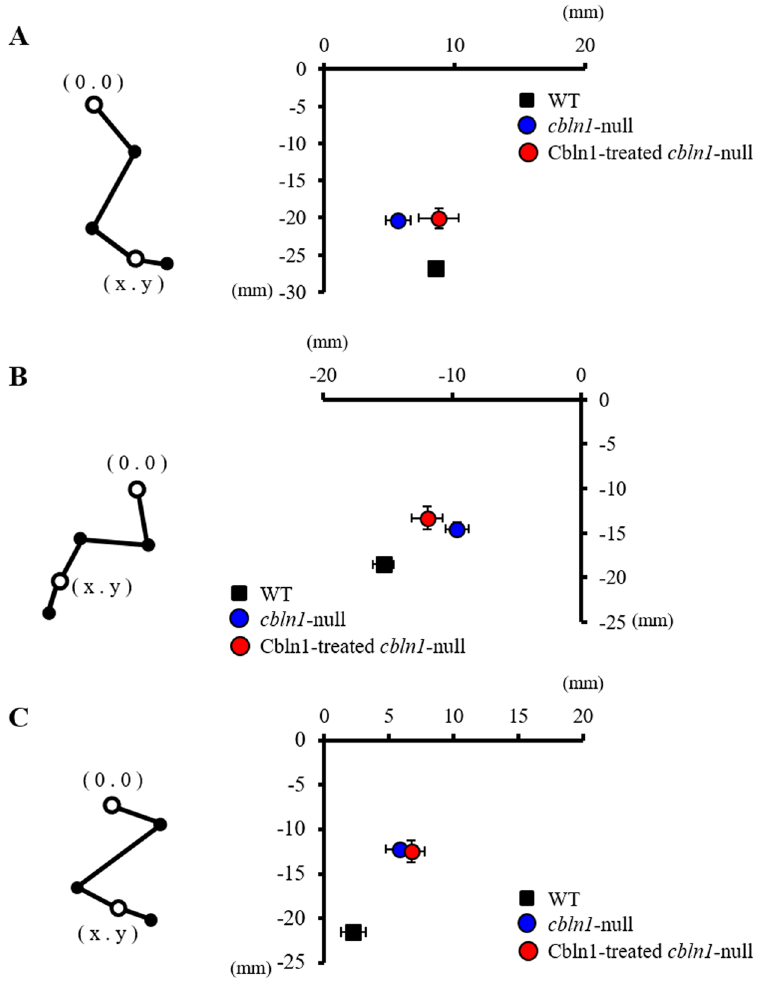
Figure 8. Position of the metatarsophalangeal (MTP) joint during the step cycle. Position of the MTP joint using the great trochanter as the origin. ( A ) Position of the MTP joint at foot contact. ( B ) Position of the MTP joint at foot lift. ( C ) Position of the MTP joint at maximal toe height. Error bars represent